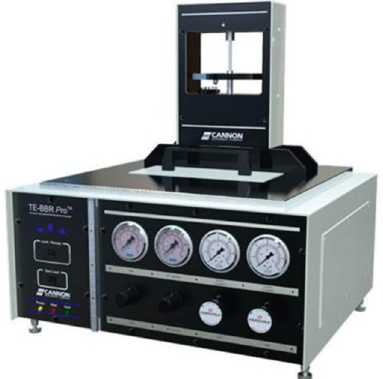
Figure 5: Low temperature bending beam